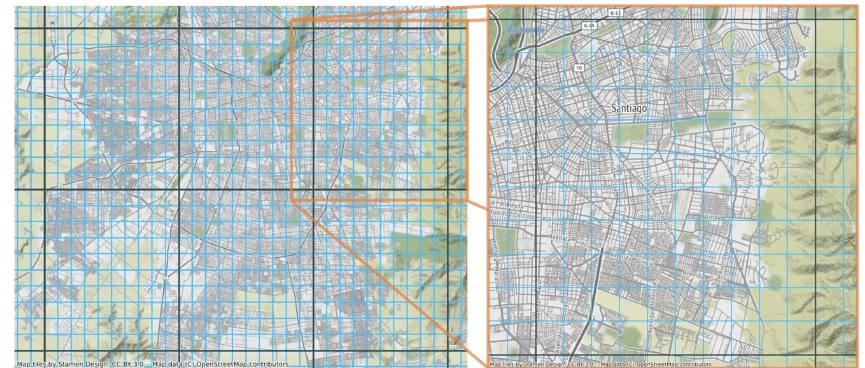
Figure 3. Map of Santiago at different scales: in blue the utilized 0 . 01 ◦ × 0 . 01 ◦ grid (approximately 1km × 1km) and in black the 0 . 1 ◦ × 0 . 1 ◦ EDGAR v5.0 grid for comparison. © OpenStreetMap contributors 2021. Distributed under the Open Data Commons Open Database License (ODbL)